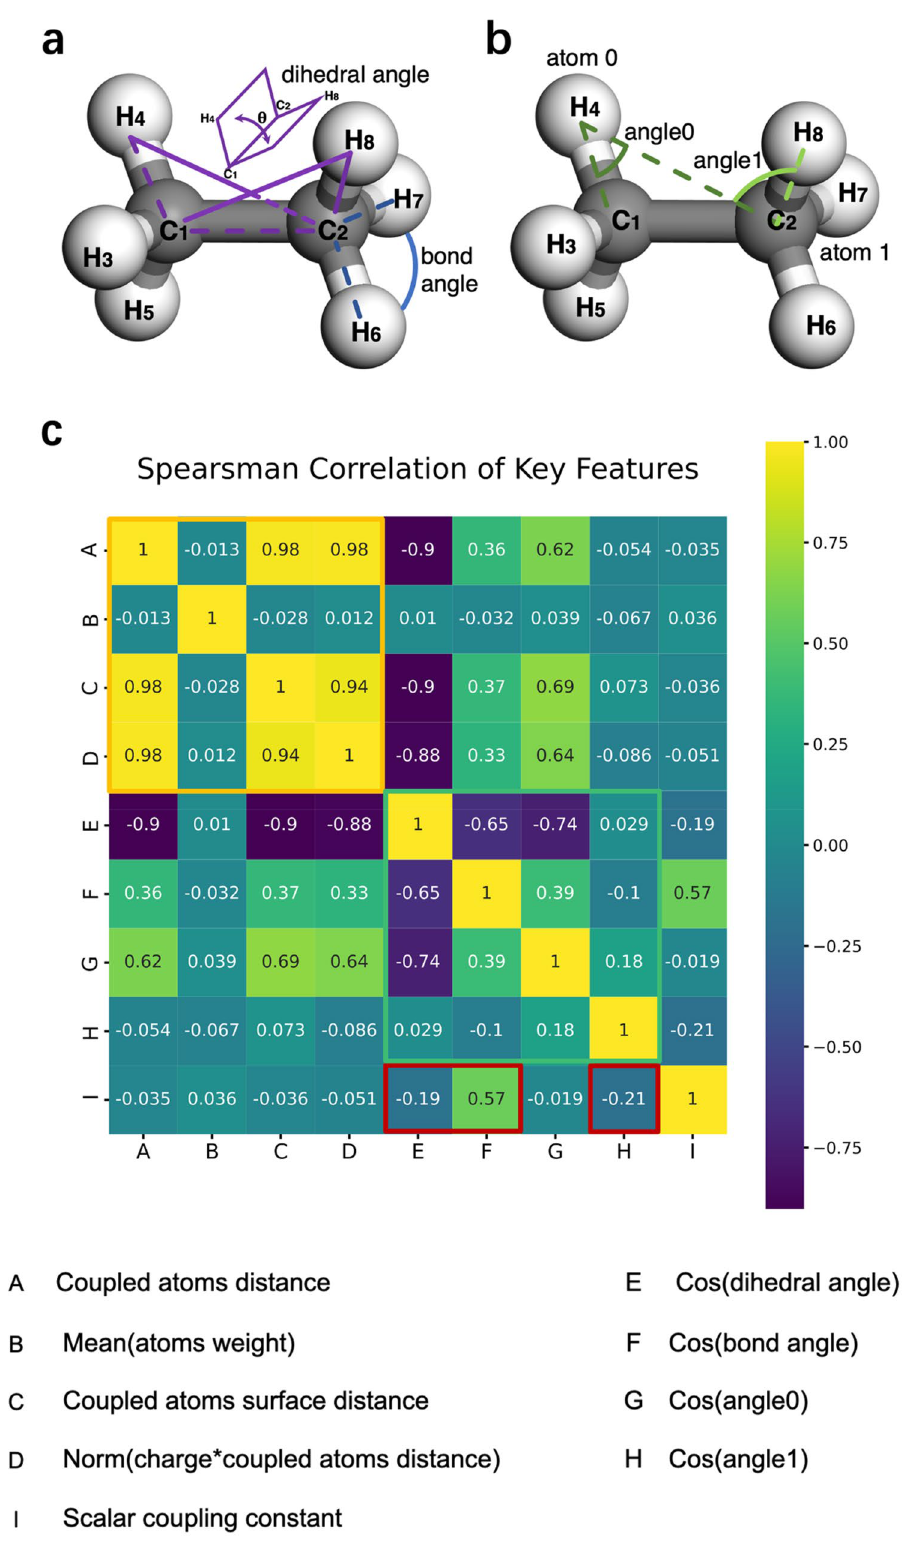
Figure 6. The description of relevant angles and Spearman correlation of key coupling features. ( a ) The description of dihedral angle and bond angle. The purple line describes the dihedral angle between the plane (H 4 -C 1 -C 2 )- and the plane (H 8 - C 2 -C 1 ) formed by the 3 J coupled atoms (H 4 and H 8 ). The blue line describes the bond angles ( ∠ H 6 C 2 H 7 ) formed by the 2 J coupled atoms (H 6 and H 7 ). ( b ) The description of the geometric angles. The green line describes angle0 and angle1, which are the geometric angles formed by coupled atoms (H 4 and C 2 ) and their nearest atom of atom0 (H 4 ) or atom1 (C 2 ). ( c ) Spearman correlation of key coupling features. In the last line, the importance of the relevant angle features to SCC are prominent. Remarkably, the cos(bond angle) has the highest correlation with the SCC among all angle